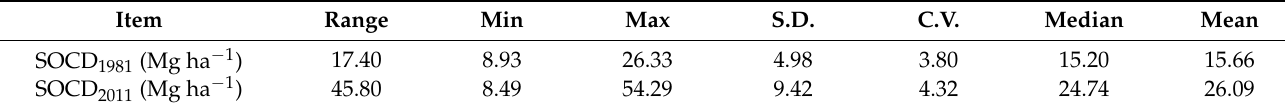
Table 1. Statistics for SOCD and soil carbon content in 1981 and